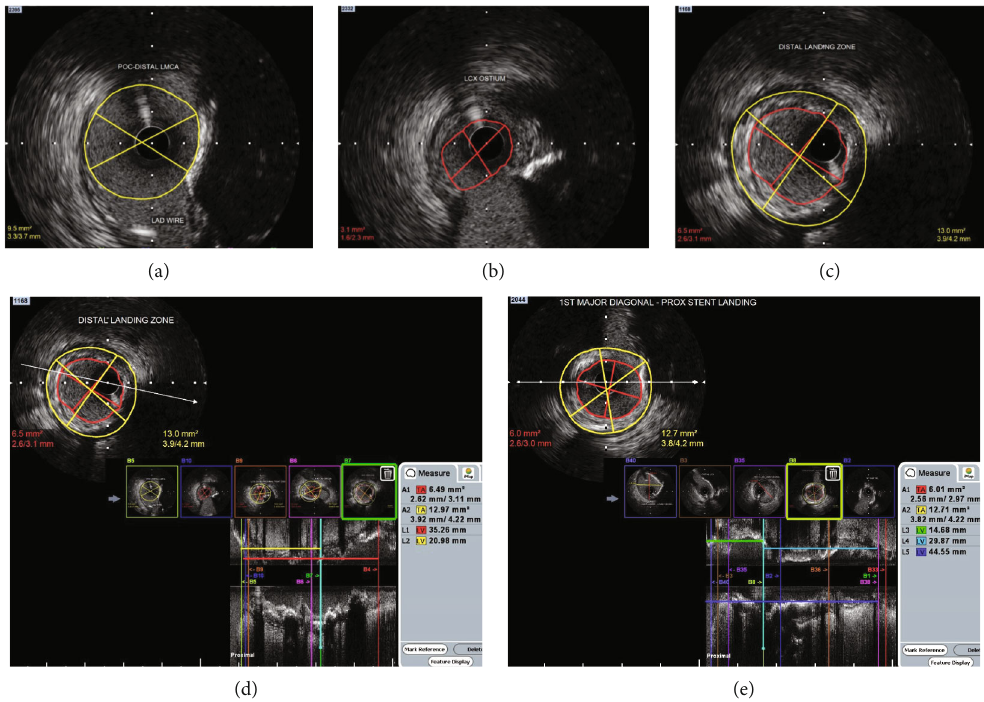
Figure 3: (a) Distal LMCA IVUS. (b) Signi fi cant disease at LCX ostium. (c) Distal landing zone in major OM. (d) IVUS image in LCX for assessing stent length. (e) IVUS in LM-LAD to decide proximal and distal stent